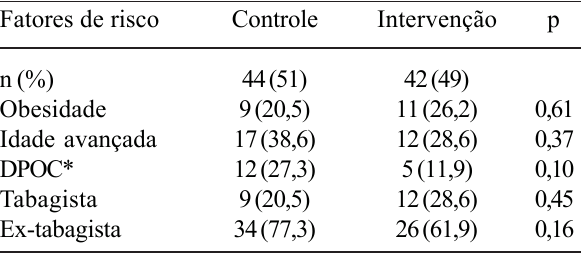
Tabela 2. Fatores de risco para complicações pulmonares pós-